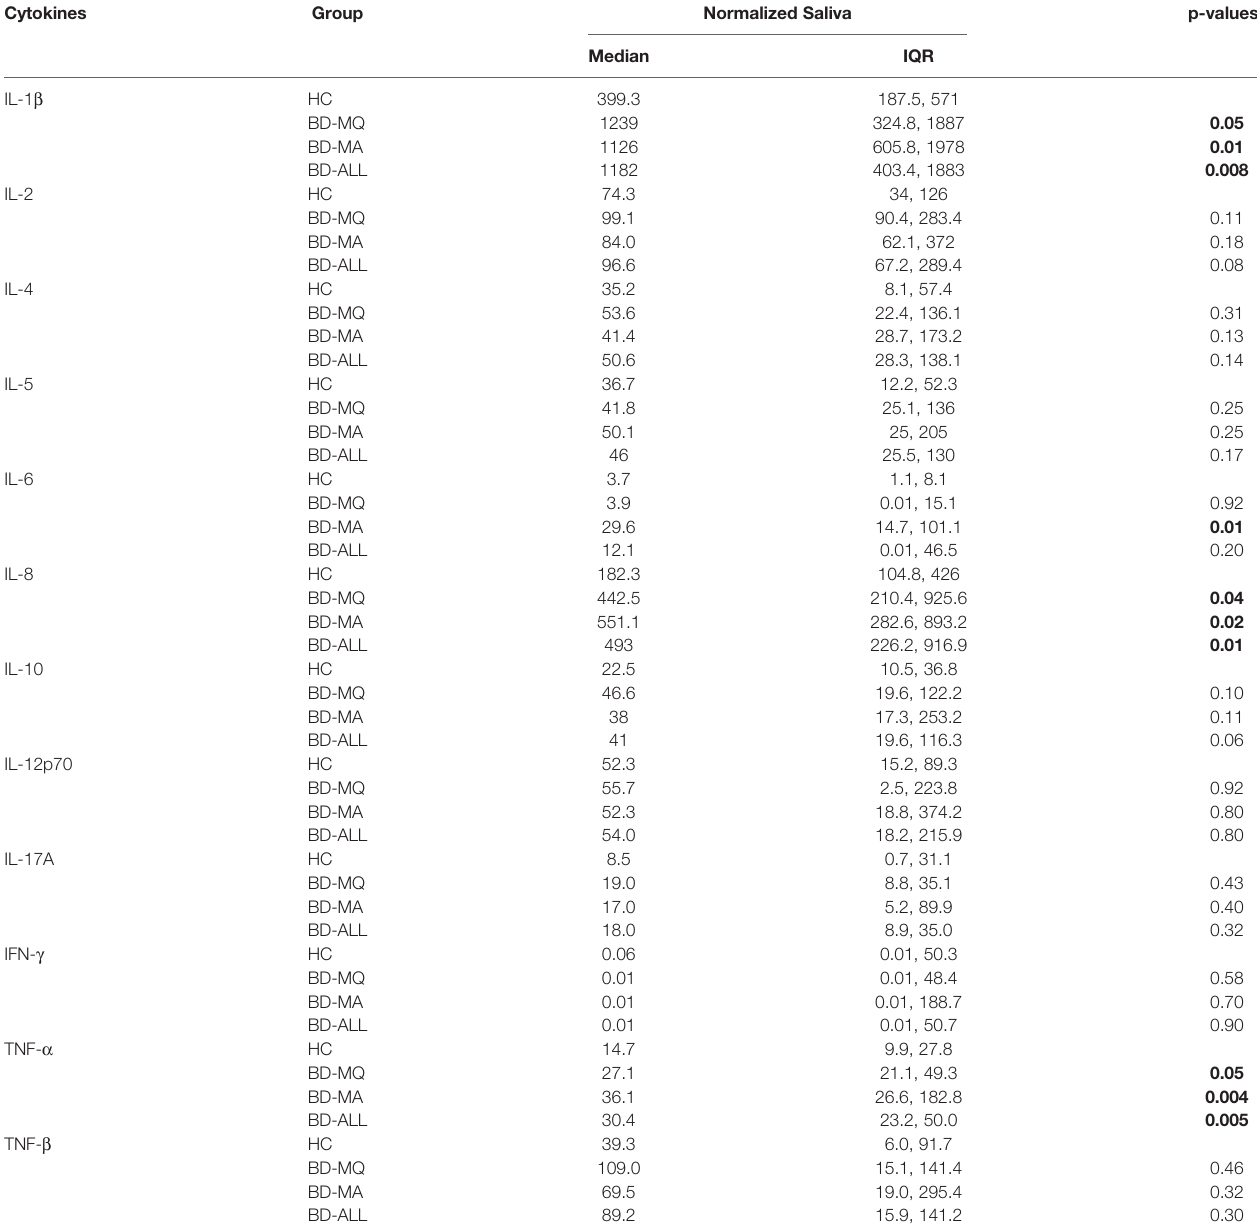
TABLE 5 | Concentrations of cytokines in normalized saliva of BD patients presenting with oral ulceration, Mouth Active (BD-MA), or without oral ulceration, Mouth Quiet (BD-MQ) compared to HC. Cytokines Group Normalized